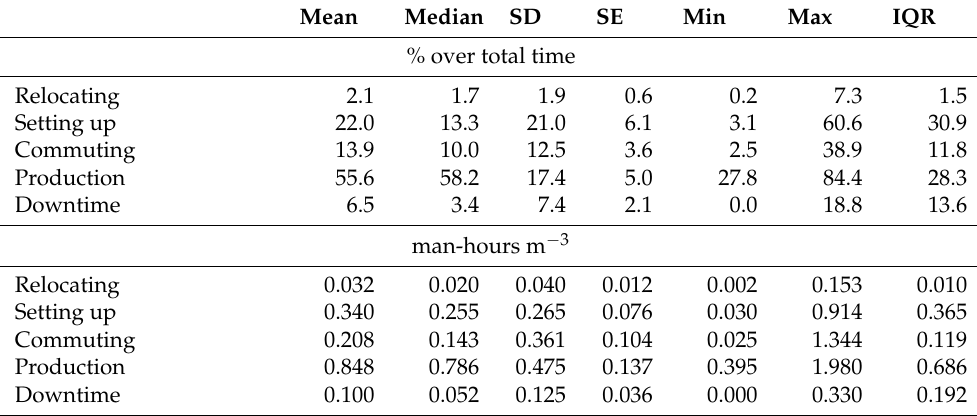
Table 5. Percent breakdown of total time (man-hours) among the main tasks and time use per m 3 and task ( n = 12).